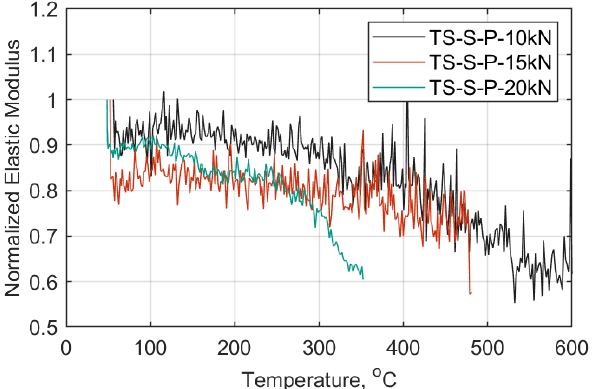
Figure 25. Normalized elastic modulus vs. temperature (°C) representative curves, TS cases.